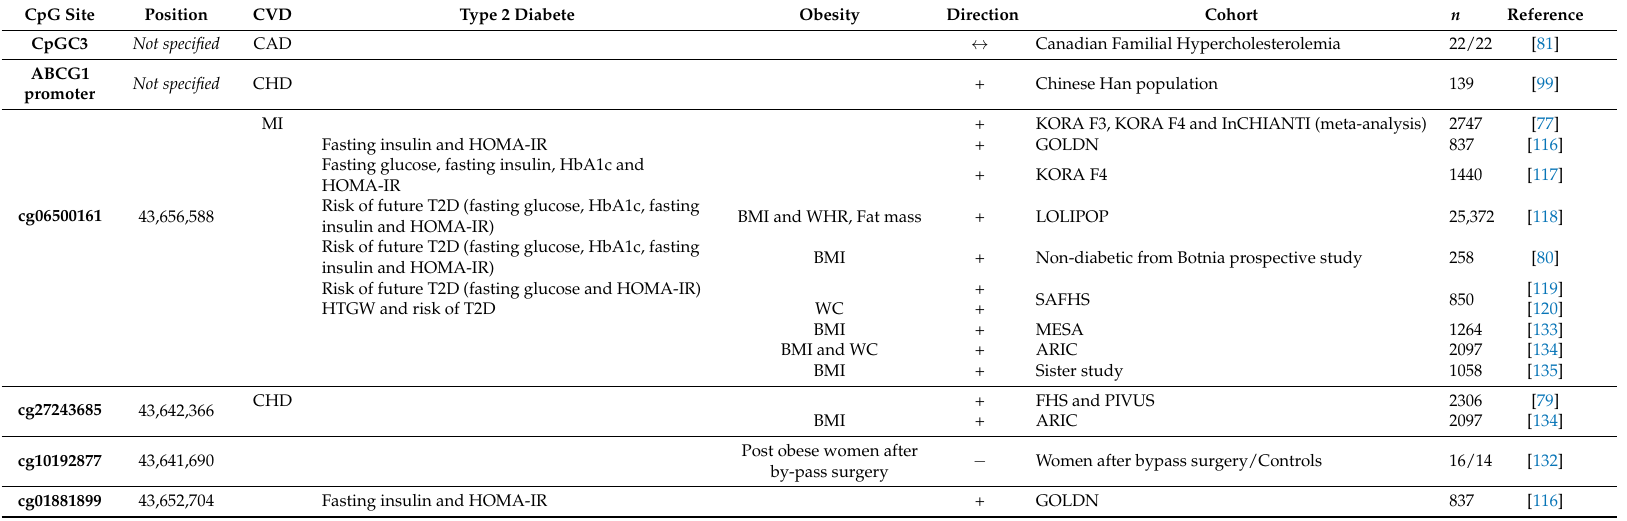
Table 2. Relation between methylation at different ABCG1 CpG loci and cardiovascular diseases, prevalence and incidence of type 2 diabete and obesity. CHD, coronary heart diseases; T2D, type 2 diabetes; MI, myocardial infarction; KORA, cooperative health research in the region of Augsburg; InCHIANTI, aging in the Chianti area; HOMA-IR, homeostatic model assessment of insulin resistance; GOLDN, genetic of lipid lowering drugs and diet network; HbA1c, glycated haemoglobin; BMI, body mass index; LOLIPOP, London life science prospective population; HTGW, hypertriglyceridemic waist; WC, waist circumference; SAFHS, San Antonio family heart study; MESA, multi-ethnic study of atherosclerosis; ARIC, atherosclerosis risk in communities; FHS, Framingham heart study; PIVUS, prospective investigation of the vasculature in Uppsala